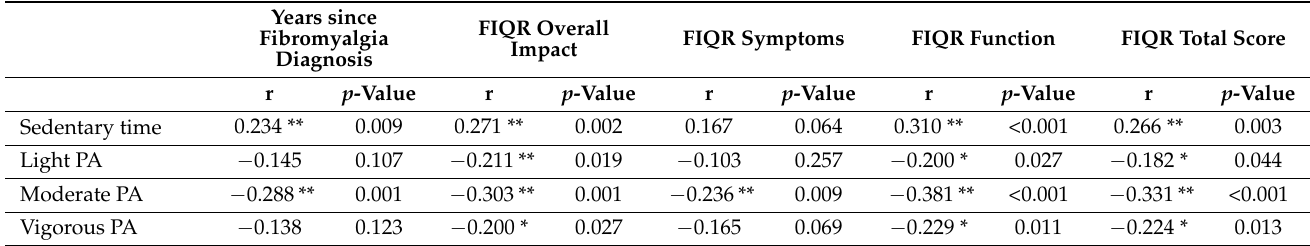
Table 2. Correlations between physical activity and fibromyalgia variables.